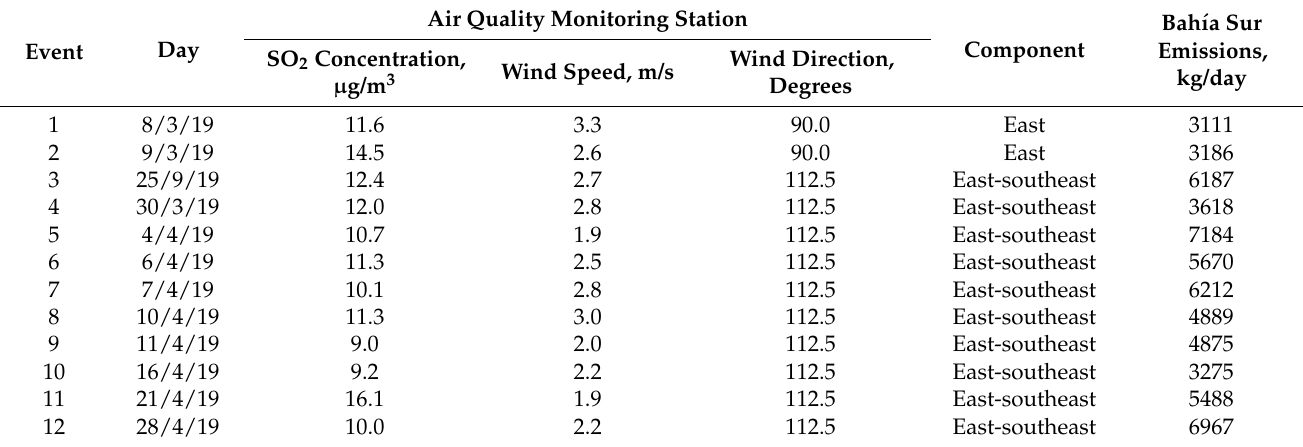
Table 3. Selected days to identify SO 2 ambient air concentration using the CALPUFF model.